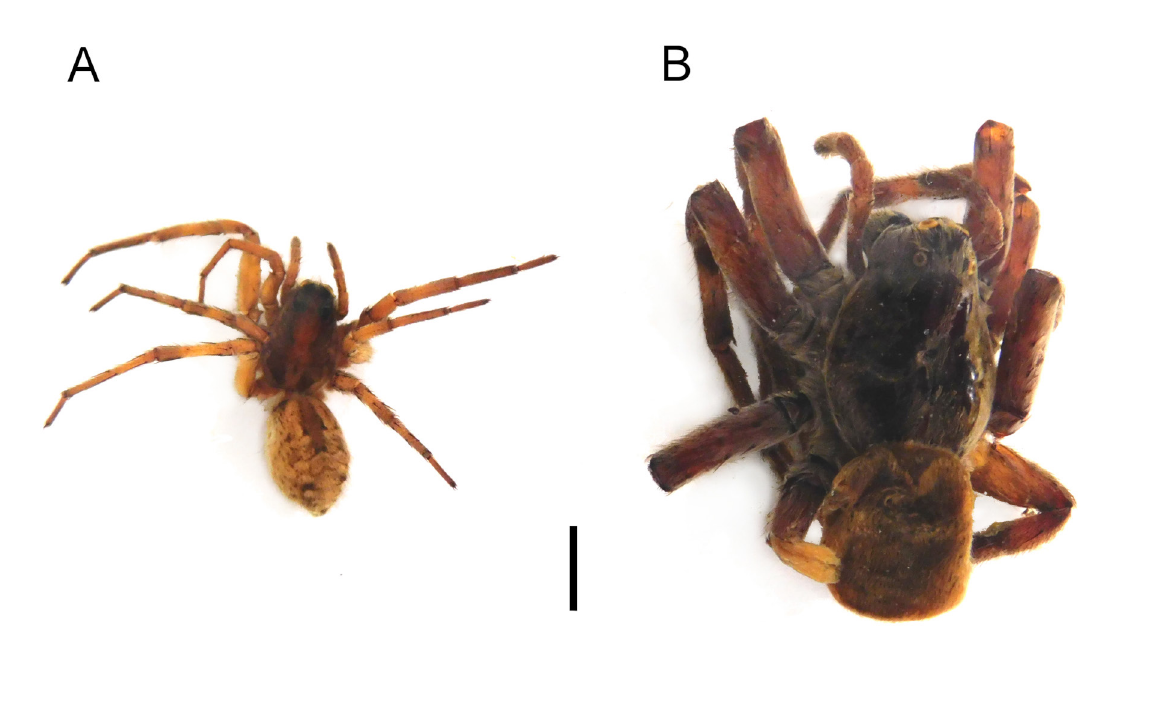
Fig. 14. Lycosa piochardi Simon,1876, size comparison of largest and smallest ♀♀ in the dataset. A . HUJ INV-AR20671. B . HUJ INV-AR20897. Scale bar = 5 mm. Photo by I. Armiach